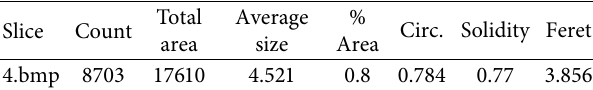
Table 4: Analyzed values at 740 °